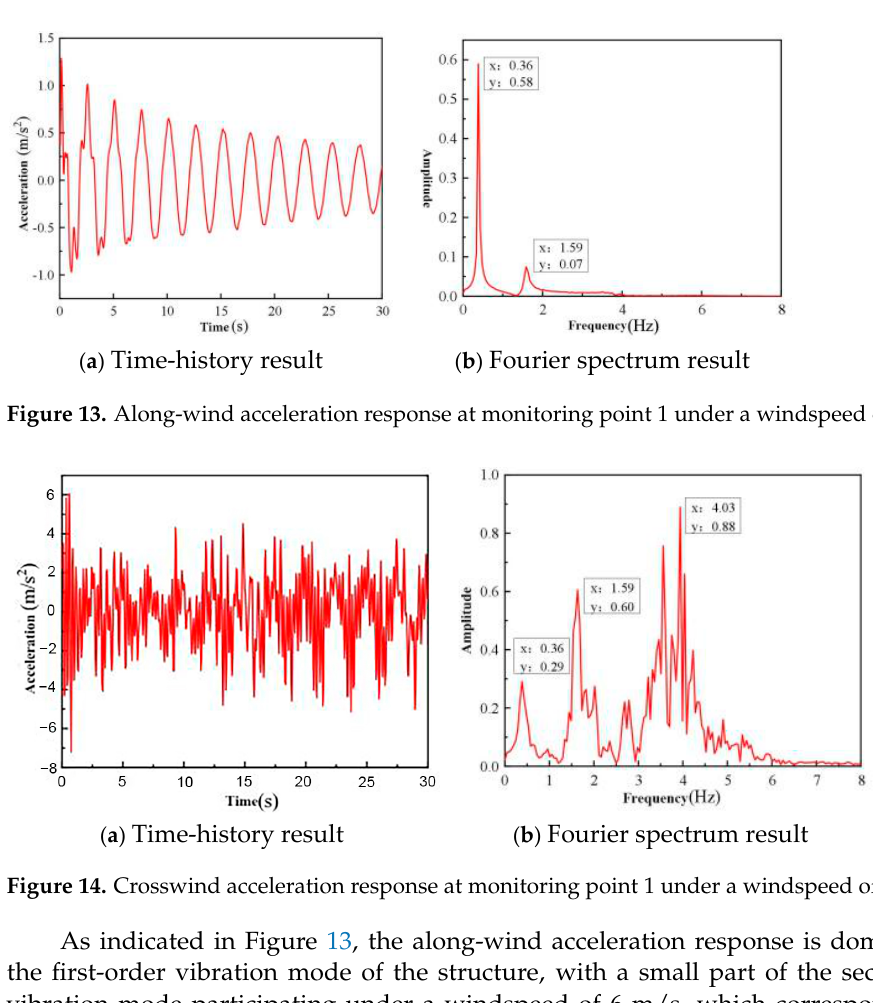
( b ) Crosswind Figure 12. Root mean square value of displacement responses of the smooth light pole structure. As demonstrated in Figure 12a, the displacements at the monitoring points increase monotonically as the windspeed increases, and there is no significant amplitude change. In addition, when the windspeed gradually increases from 1 m/s to 12 m/s, the growth rate of the root mean square value of the displacements of the structure also increases. The maximum displacements at monitoring points 1, 2 and 3 are 35.9 mm, 23.0 mm, and 7.1 mm, respectively. Figure 12b shows that the displacements at all the monitoring points fluctuate significantly within the windspeed range of 5~8 m/s, which indicates that vortex-induced vibration occurs. In particular, when the windspeed approaches 6 m/s, the root mean square value of the displacement at each monitoring point reaches its maximum value, i.e., 18.3 mm at monitoring point 1, 8.9 mm at monitoring point 2, and 3.0 mm at monitoring point 3. 3.5.2. Analysis of Wake Shedding Frequency According to the above displacement response results, one can find that significant vortex-induced vibration occurs when the windspeed is 6 m/s, and the largest displace-